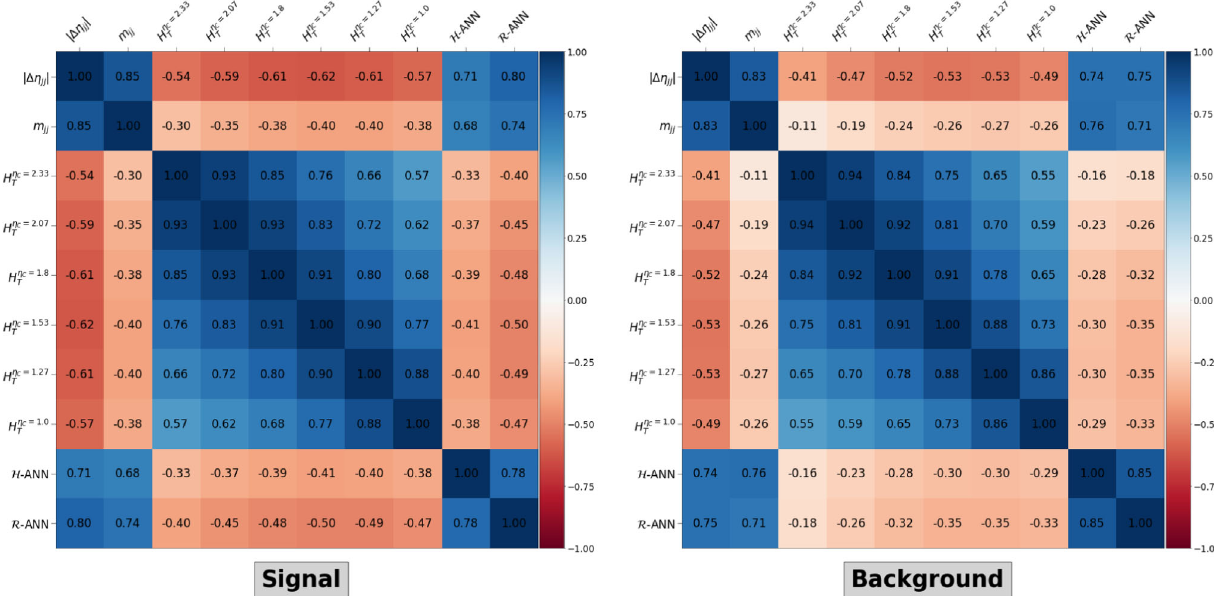
Fig. 21 Correlation between the high-level variables H and the network-outputs of R -ANN and H -ANN for (left) signal and (right) background. For better representation we have chosen variables with non-negligible correlations with the network